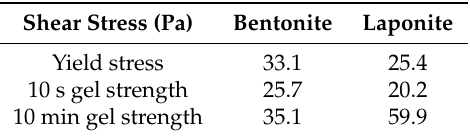
Table 5. The yield stress measured in accordance with Zamora and Power [21,22], and gel strength measured in accordance with oilfield standards [19,23,24] for the bentonite and laponite